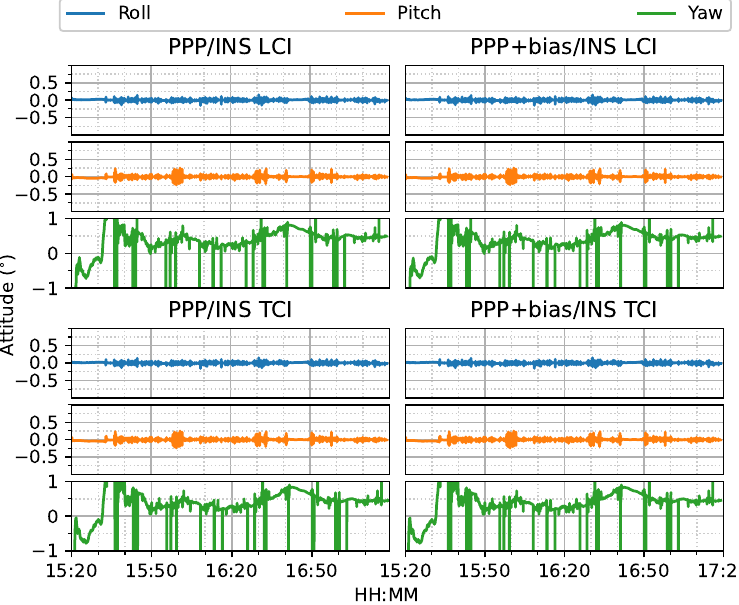
Figure 33. Real-time GPS/Galileo PPP/INS attitude errors of city center test on 27 January 2022 with respect to IE RTK/INS TCI